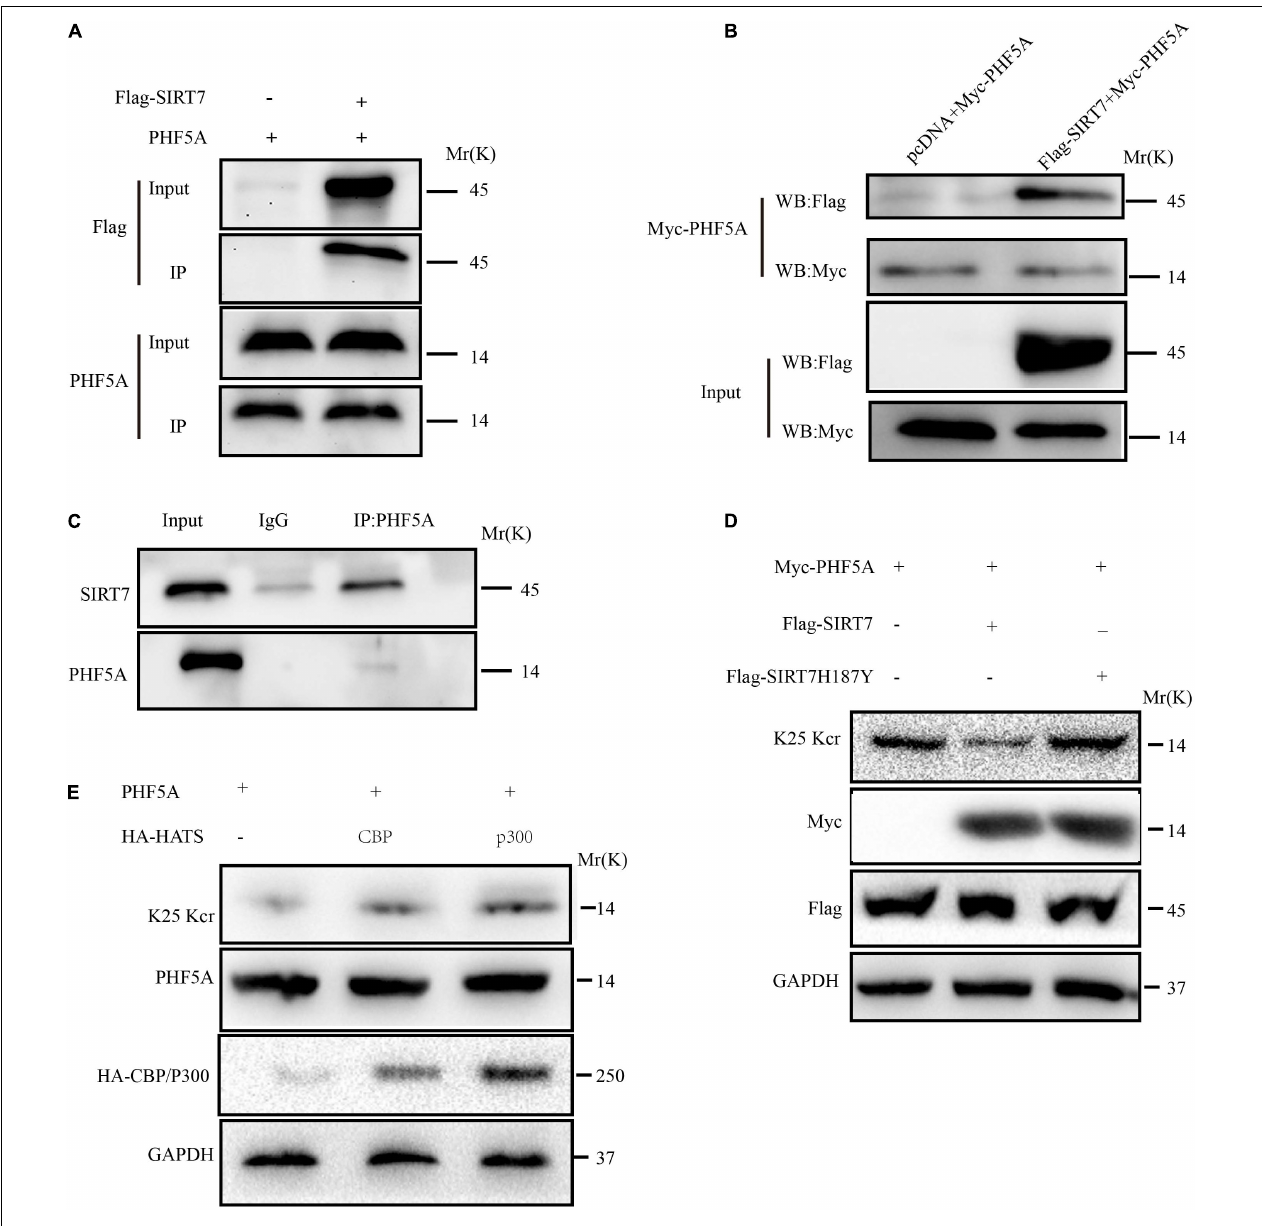
FIGURE 6 | SIRT7 decrotonylated PHF5A at K25. (A) Semi-exogenous Co-IP confirmed that SIRT7 has an exogenous interaction with PHF5A. Semi-exogenous Co-IP detected the interaction between exogenous SIRT7 and endogenous PHF5A in 2BS fibroblast transduced with lentiviruses expressing Flag-SIRT7. (B) Exogenous Co-IP confirmed that SIRT7 has an exogenous interaction with PHF5A. Exogenous Co-IP detected the interaction between exogenous SIRT7 and exogenous PHF5A in 2BS fibroblast transduced with lentiviruses expressing Flag-SIRT7, and myc-PHF5A, respectively. (C) Endogenous Co-IP confirms that SIRT7 and PHF5A have an endogenous interaction. (D) The PHF5A K25 site-specific Kcr antibody confirmed SIRT7-mediated decrotonylation of PHF5A at K25. (E) CBP/p300 increased crotonylation of PHF5A at K25; HEK293T cells were transfected with plasmids as indicated, and indicated proteins were immunoblotted by the corresponding antibody. All experiments were repeated three times